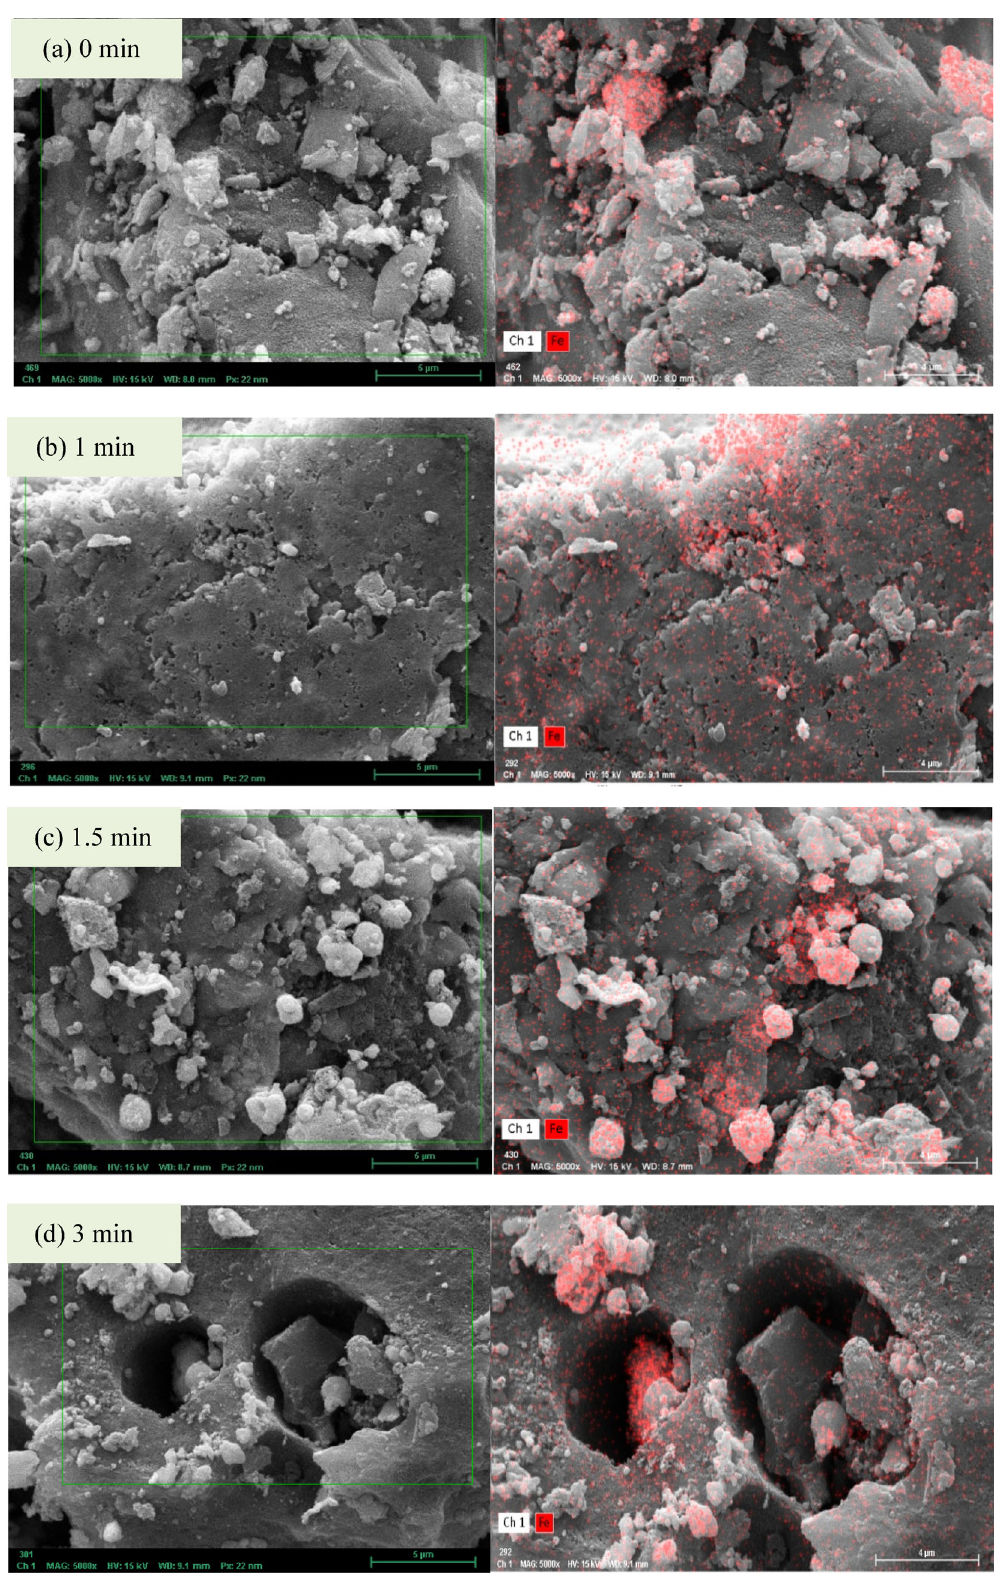
Fig. 5 Surface morphology and Fe catalyst distribution of semi-char from YCW gasification with 5 wt% IWC loaded at 1000 (cid:3)